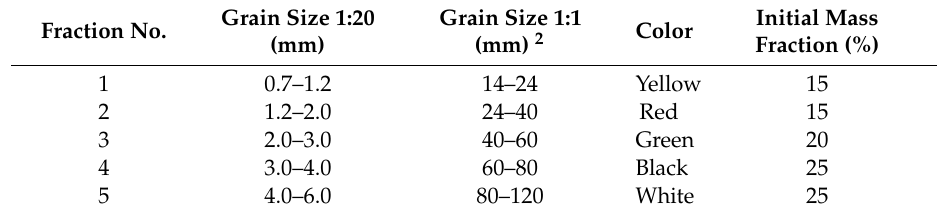
Table 2. Grain size classes of the 1:20 scale experiments and corresponding grain size classes at 1:1, initial mass fraction (%) and non-uniformity parameters 1 U and σ